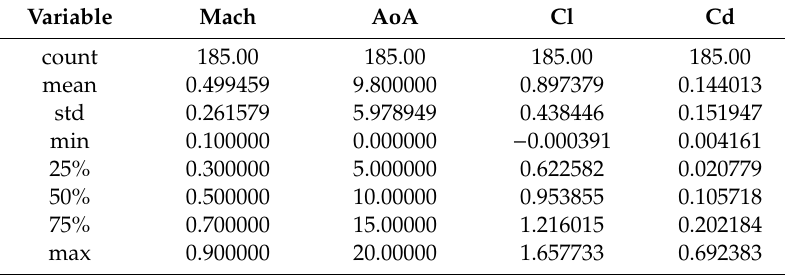
Table 3. Statistics of the aerodynamic database (NACA0012).